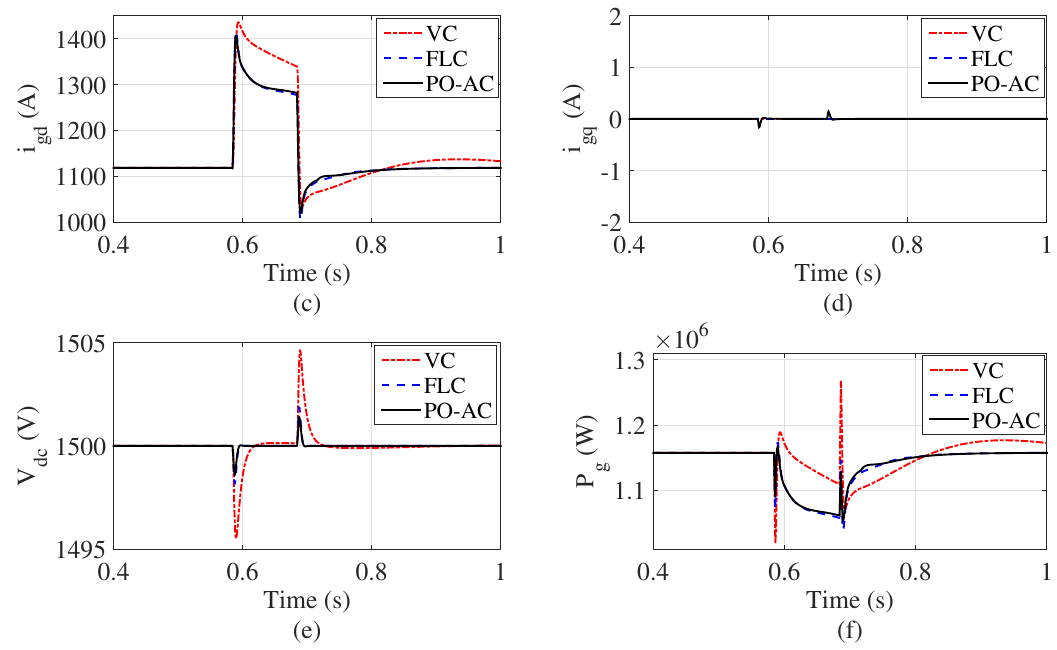
Figure 14. Responses of the grid to constant wind speed with protection under grid voltage dips. ( a ) d-axis voltage V gd . ( b ) q-axis voltage V gq . ( c ) d-axis current i gd . ( d ) q-axis current i gq . ( e ) DC-Link Voltage V dc . ( f ) Active grid power P g .